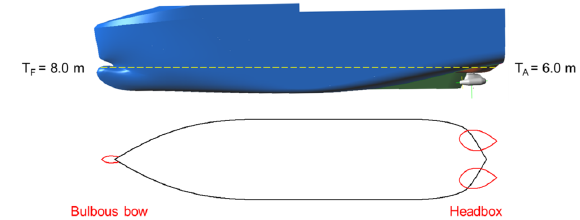
Figure 5: Icebreaking waterline of the CIVArctic vessel (double-acting vessel).